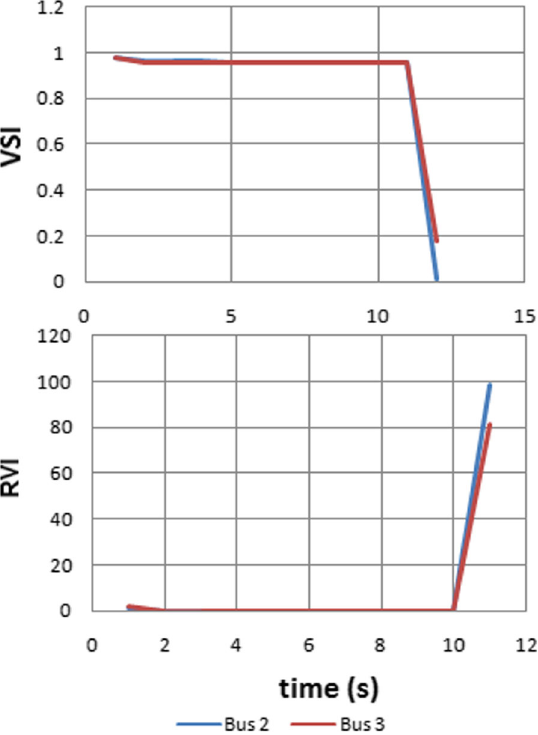
Fig. 12 Voltage Stability Index and RVI on N-1 contingency